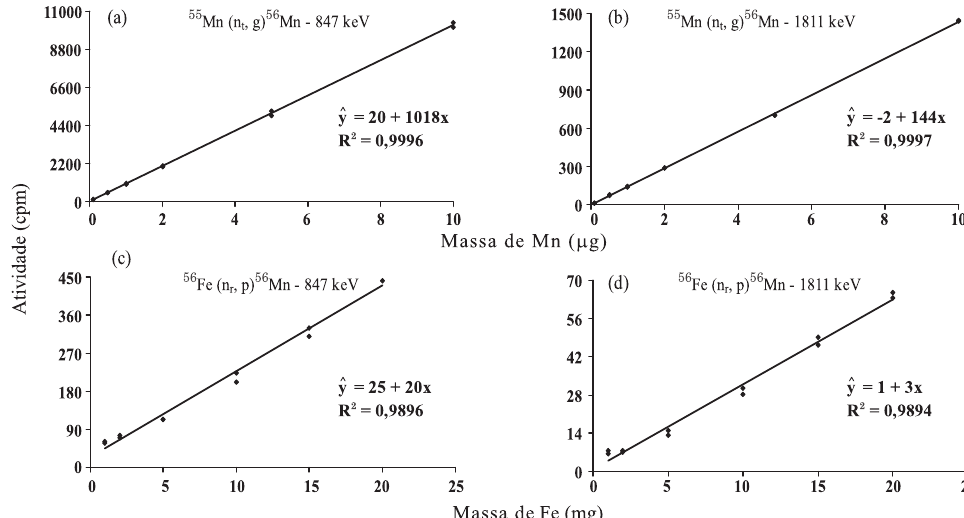
Figura 1. atividades (cpm) do 56 mn obtidas de padrões de mn (a, b) e de Fe (c,